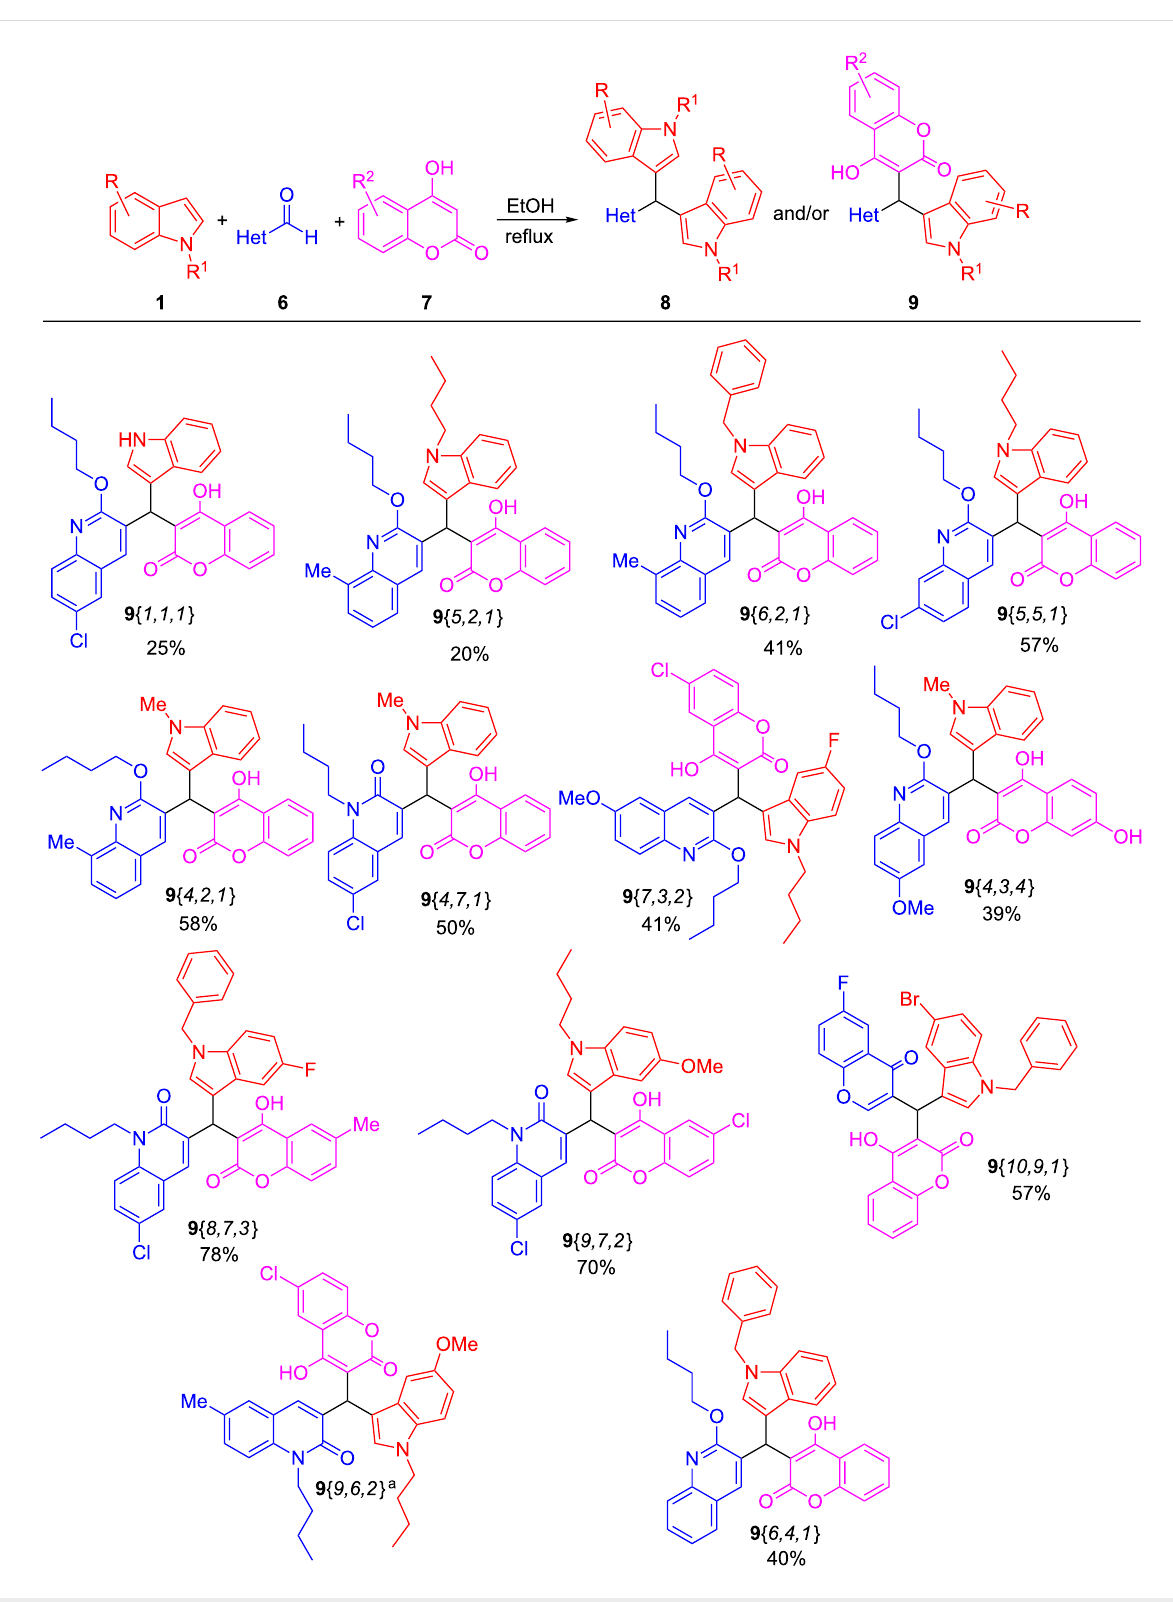
Figure 2: Three-component synthesis of tris(heteroaryl)methane triads 9 . a This product was obtained as an inseparable mixture along compound 8 { 9,9,6 } (see Supporting Information File